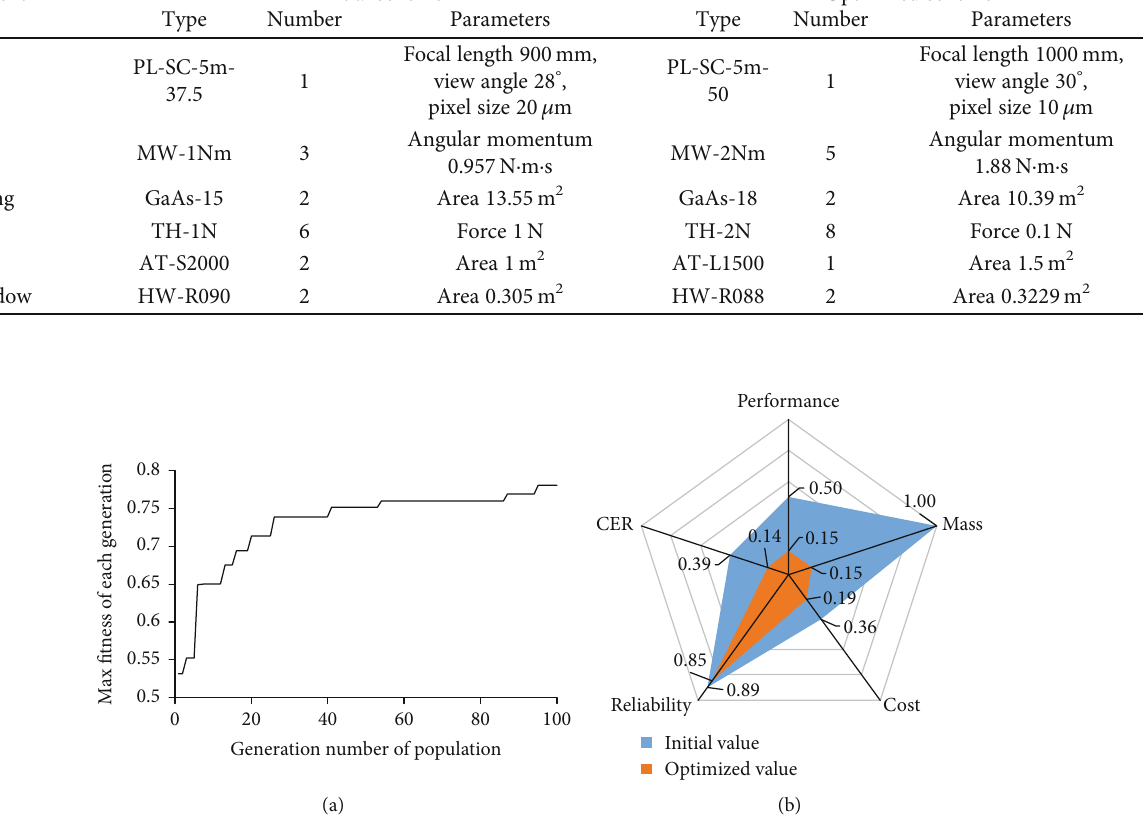
Figure 5: Optimization results of fi tness and system indexes. (a) Relationship between GP ’ s optimal fi tness value and generation number of population. (b) Optimization results of normalization system